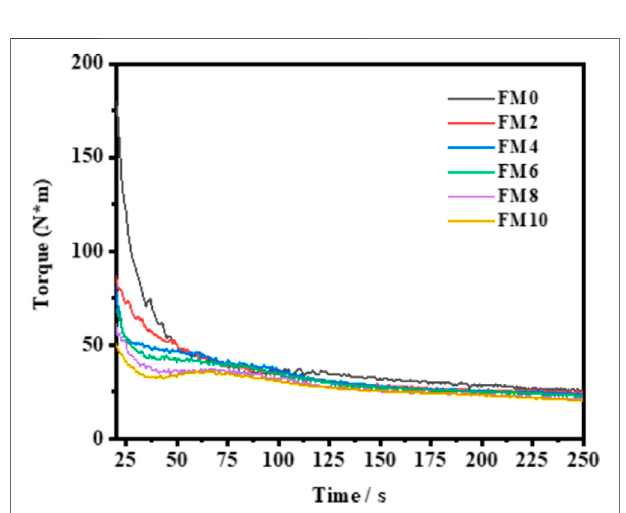
FIGURE 7 | Torque of PCTFE and its blends as a function of